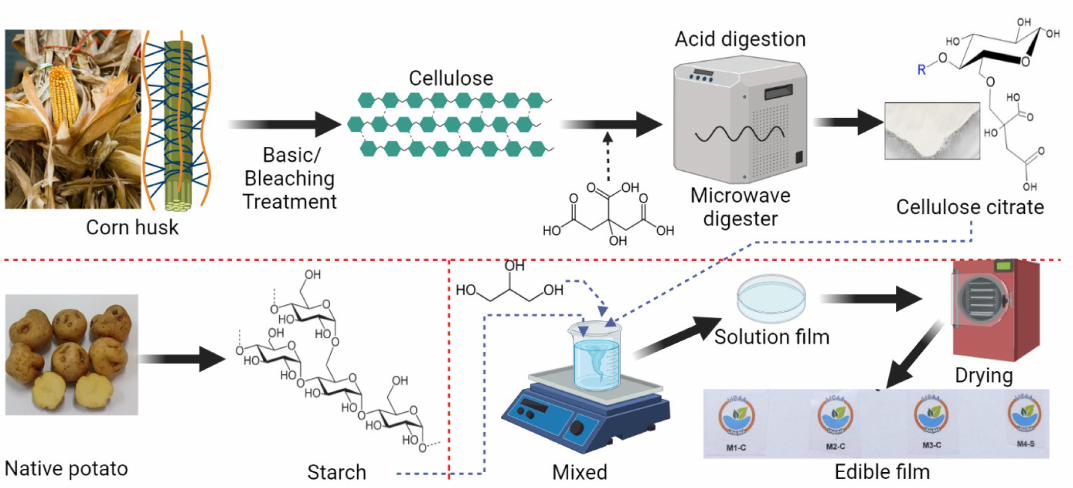
Figure 1. Films elaboration